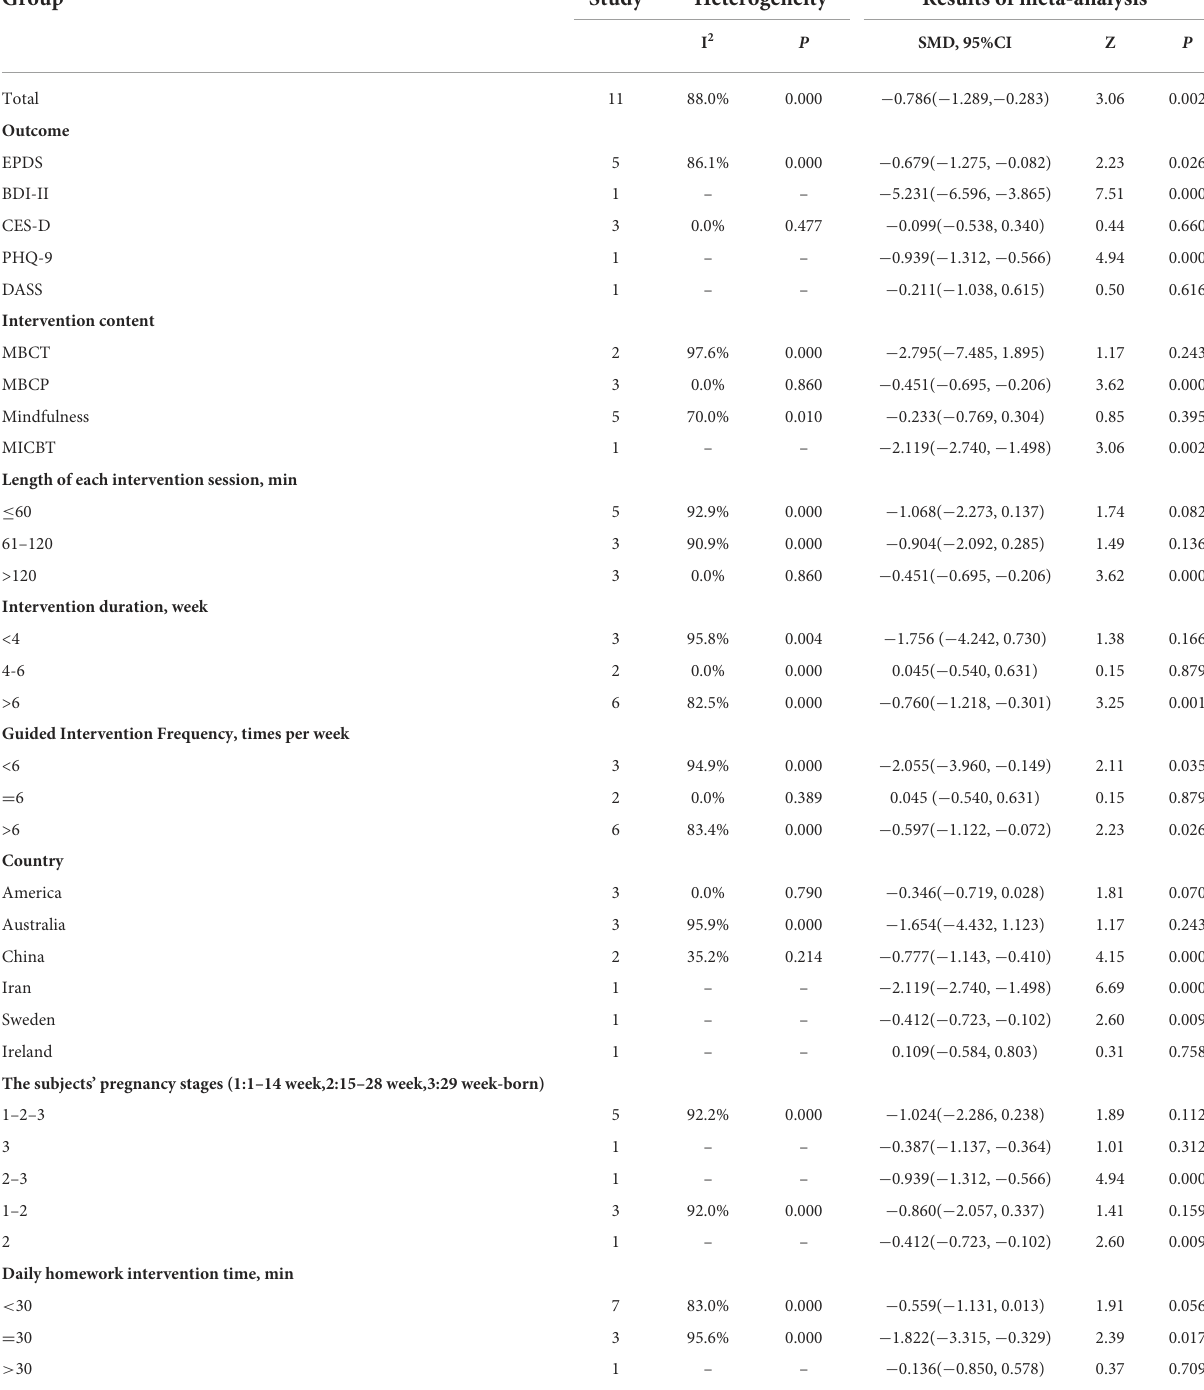
TABLE 3 Subgroup analysis of the effect of mindfulness meditation on depression during pregnancy. Group Study Heterogeneity Results of